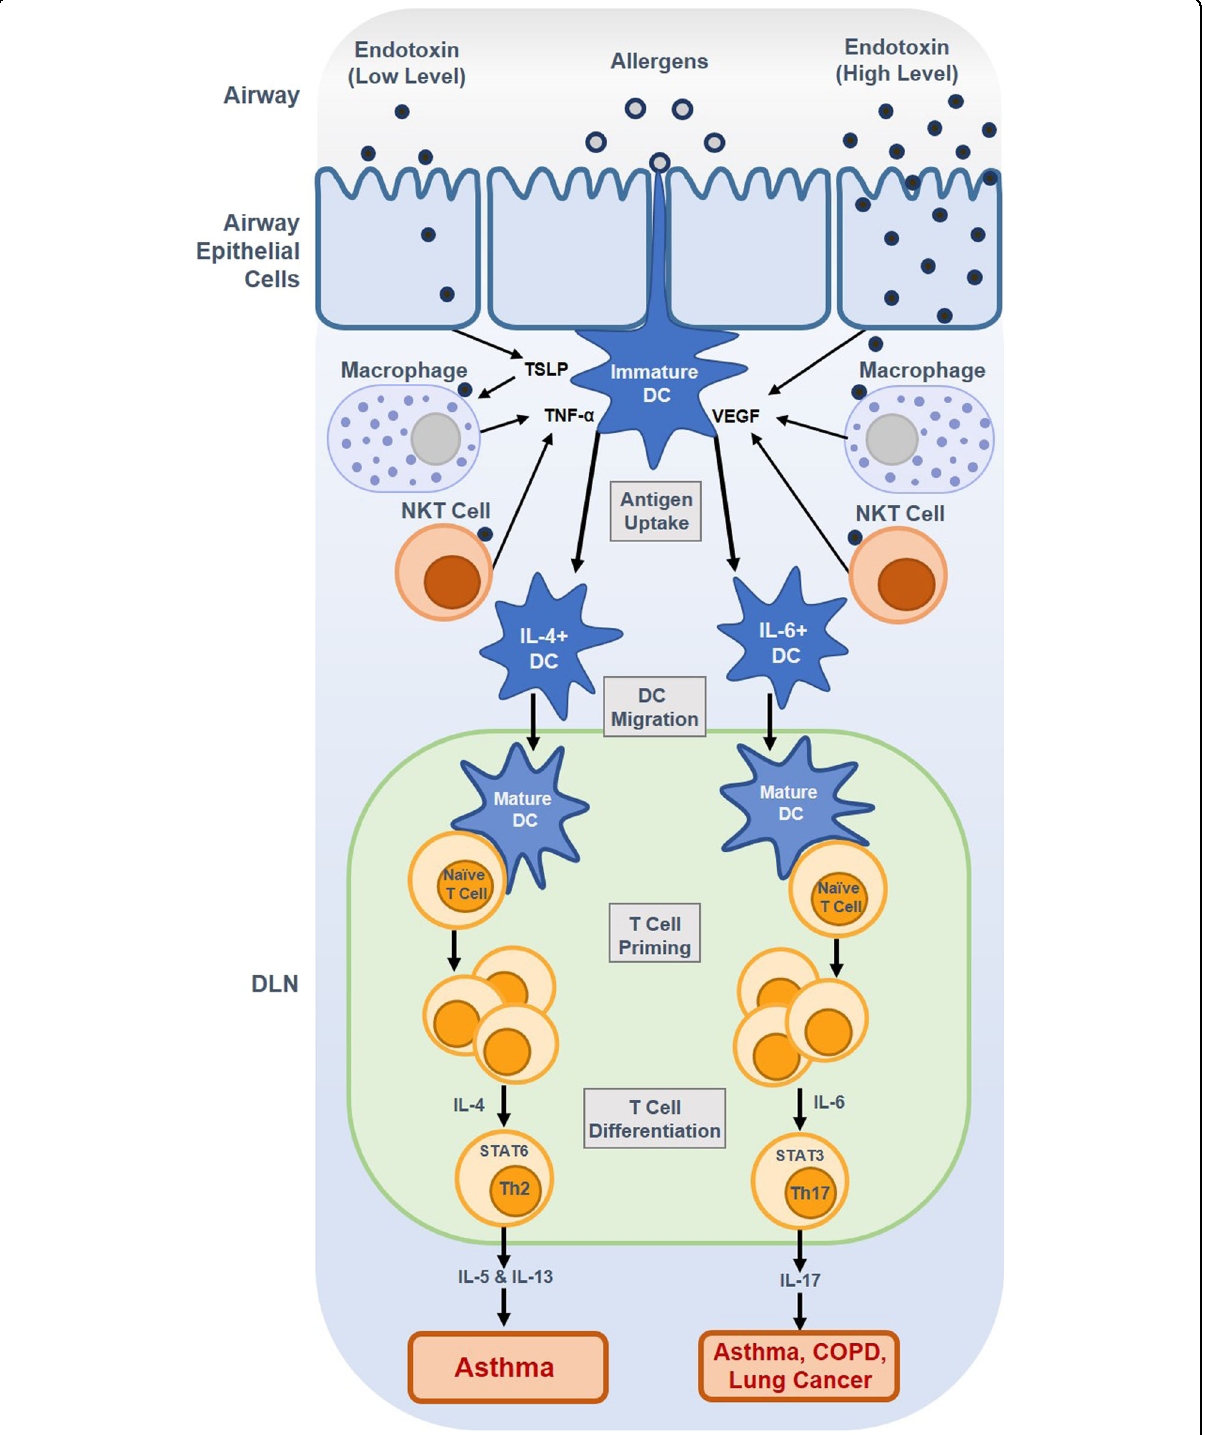
Fig. 2 Low level-lipopolysaccharide (LPS) in the airway is absorbed into airway epithelial cells and immune cells, such as macrophages, natural killer T (NKT) cells, and dendritic cells (DCs). Exposure to low levels of LPS in the airway is associated with Th2 immune response and Th2 cytokines, such as IL-5 and IL-13, which contribute to the development of asthma. High levels of LPS in the airway induce vascular endothelial growth factor (VEGF). High levels of LPS is related with Th17 immune response and increased Th17 cytokines, such as IL-17, that contributes to the development of asthma, COPD, and lung